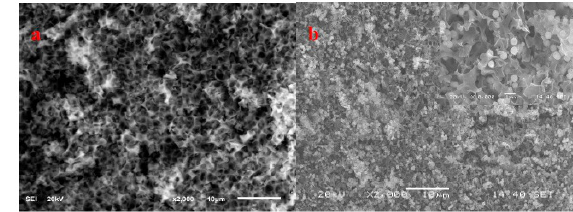
Figure 4: SEM micrographs of (a) PRs and (b) HPRs